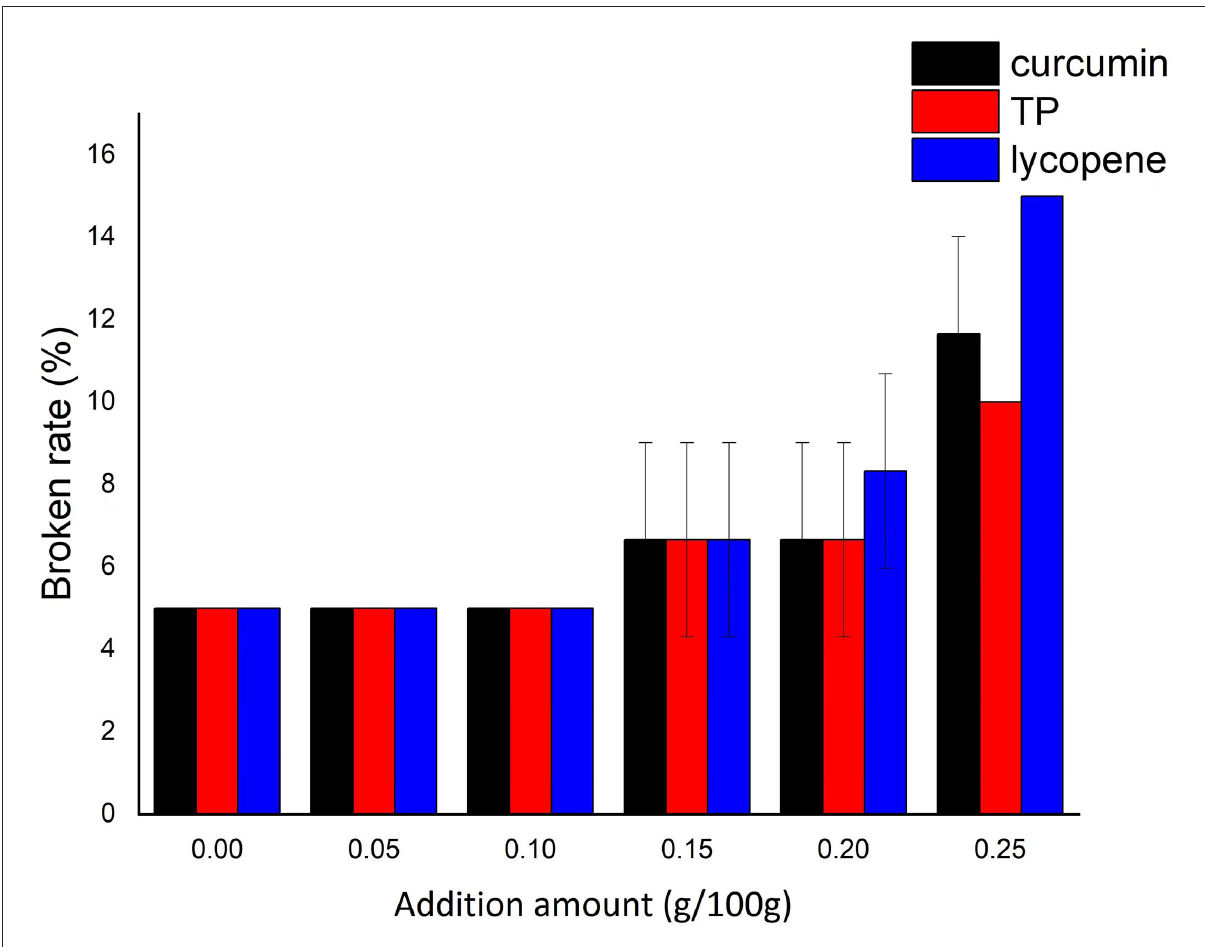
FIGURE1 Effect of additional amount of NAs on the broken rate of